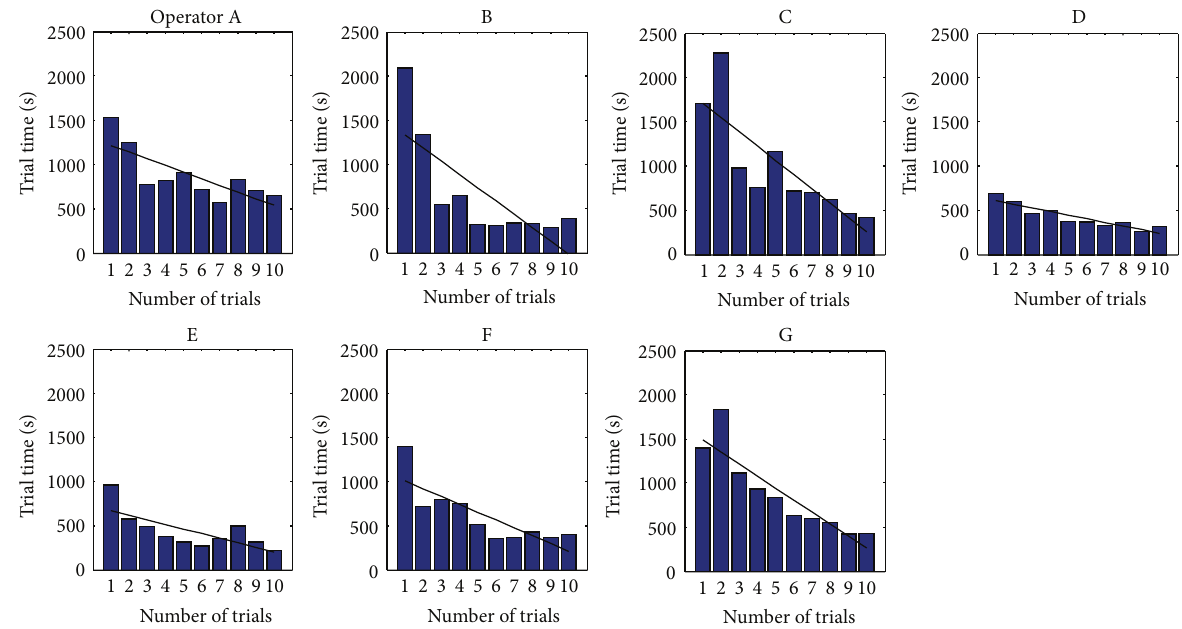
Figure 4: Transition of the trial time for all operators ( T